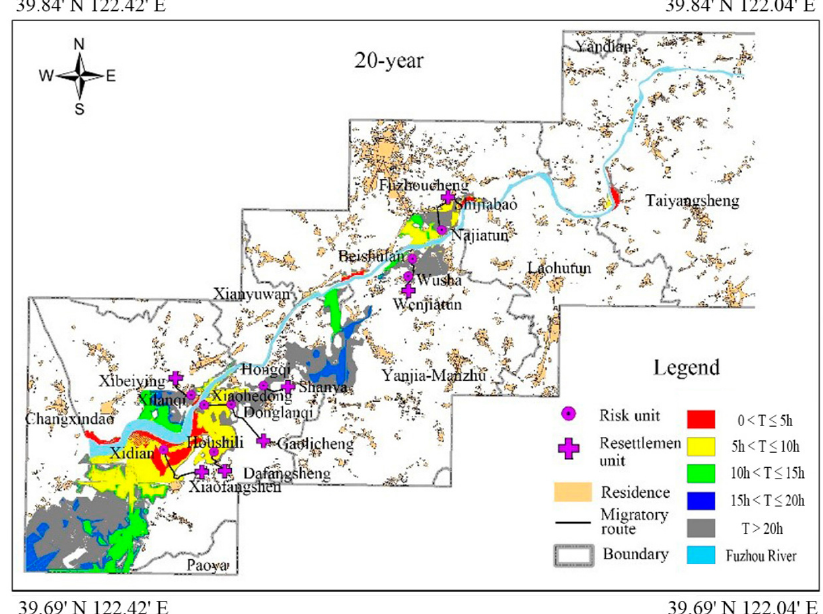
Figure 1. Schematic diagram of study area. Figure 16. Evacuation plan of 20-year return period